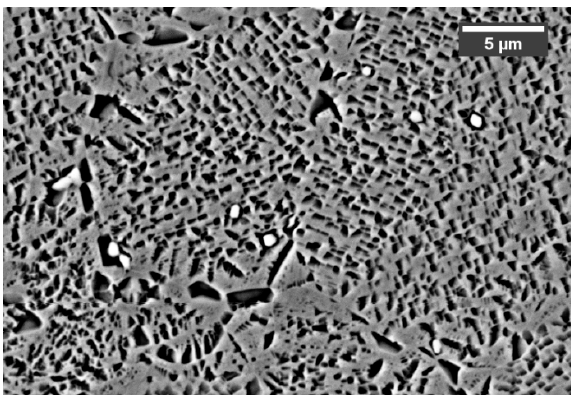
Figure 9. Carbides of as-hipped Astroloy: they appear bright when observed with backscattering detector.